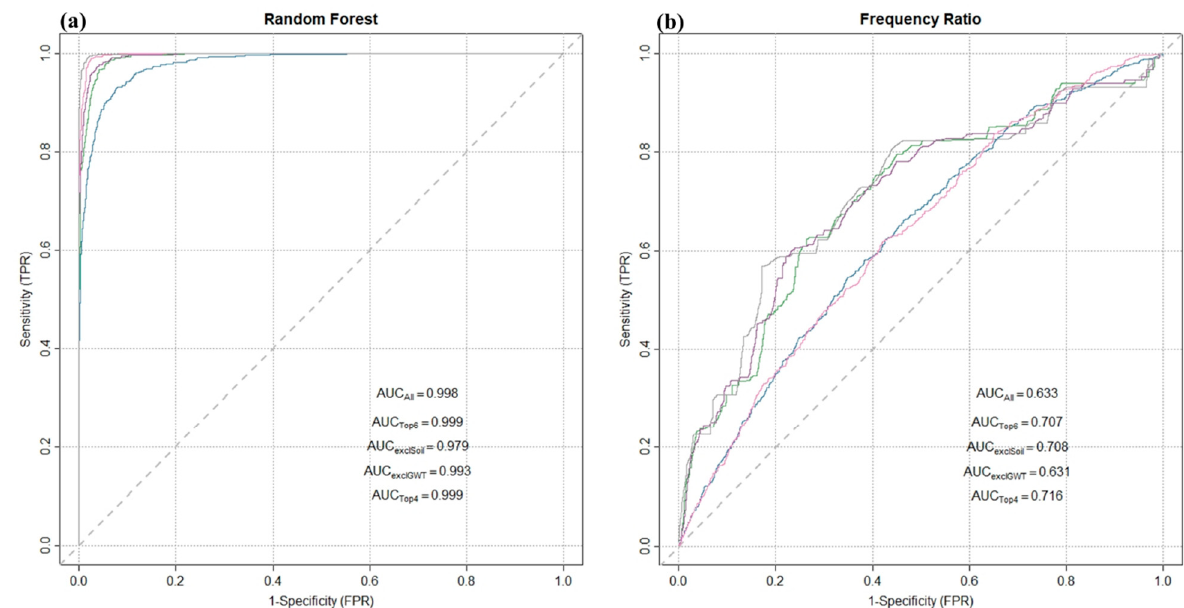
Figure 7. Receiver operating characteristic (ROC) curves for the random forest ( a ) and frequency ratio ( b ) models. Model performance was evaluated for five different cases: (1) All: using all predictor factors; (2) Top6: using the top six factors, as presented in Figure 4c; (3) exclSoil: using all top six gully-predictor factors except soil type; (4) exclGWT: using all top six gully-predictor factors except GWT; and (5) Top4: using the top four factors, as presented in Figure 4c.